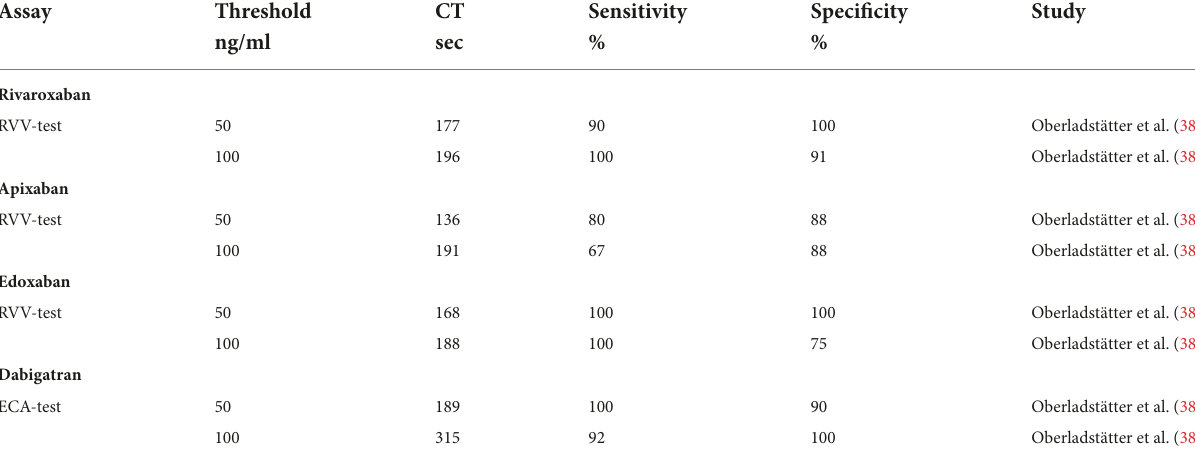
TABLE 1.3 Study defined ClotPro clotting time (CT) thresholds for detection of residual DOAC plasma concentration stratified by